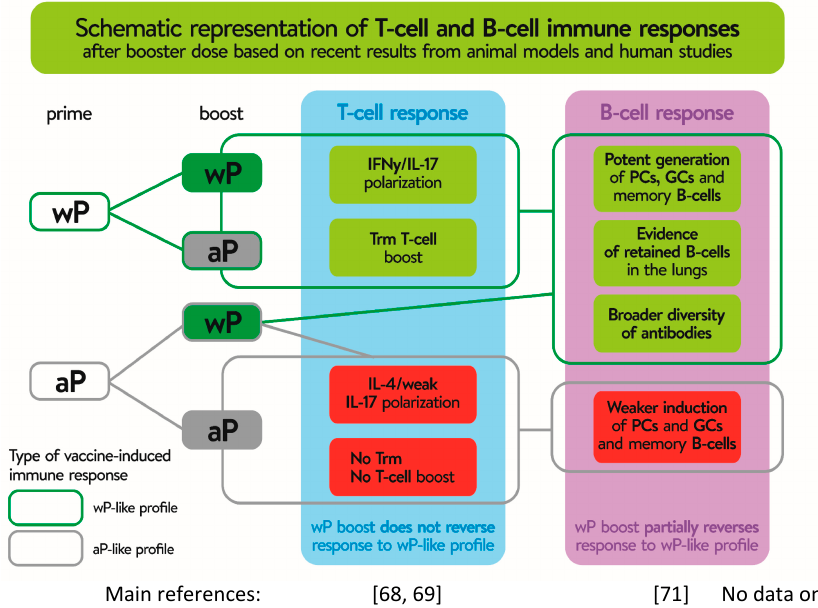
Figure 3. Different T and B cell response, depending on use whole-cell (wP) or acellular (aP) pertussis component during priming and booster immunization. Gray boxes show the effect of priming and booster immunization with aP vaccines. Green boxes show the same effect on T and B cells after prime immunization with wP, irrespective of aP or wP use as a booster, while reversion of the B cell profile after using as a booster wP after priming with aP. Stronger and faster effects of the boost dose on either T or B cell response are shown on a green background. Non-or negative effect on lymphocyte stimulation after boost vaccination is shown in red background. Trm—tissue-resident memory CD4 T cells; PCs—plasma cells; GCs—germinal centers.